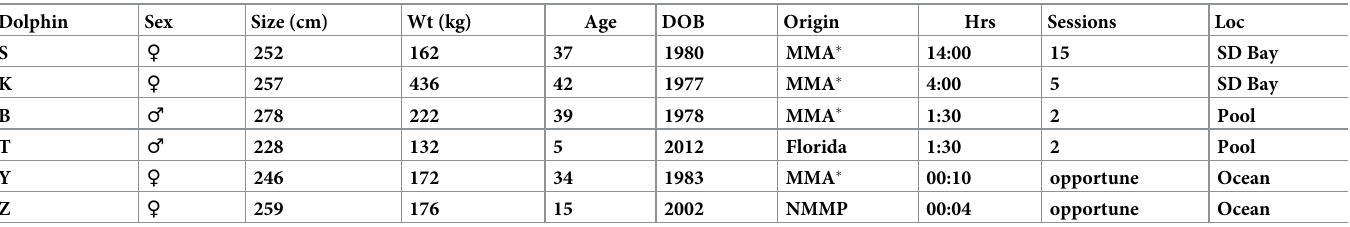
Table 1. Navy dolphins observed.